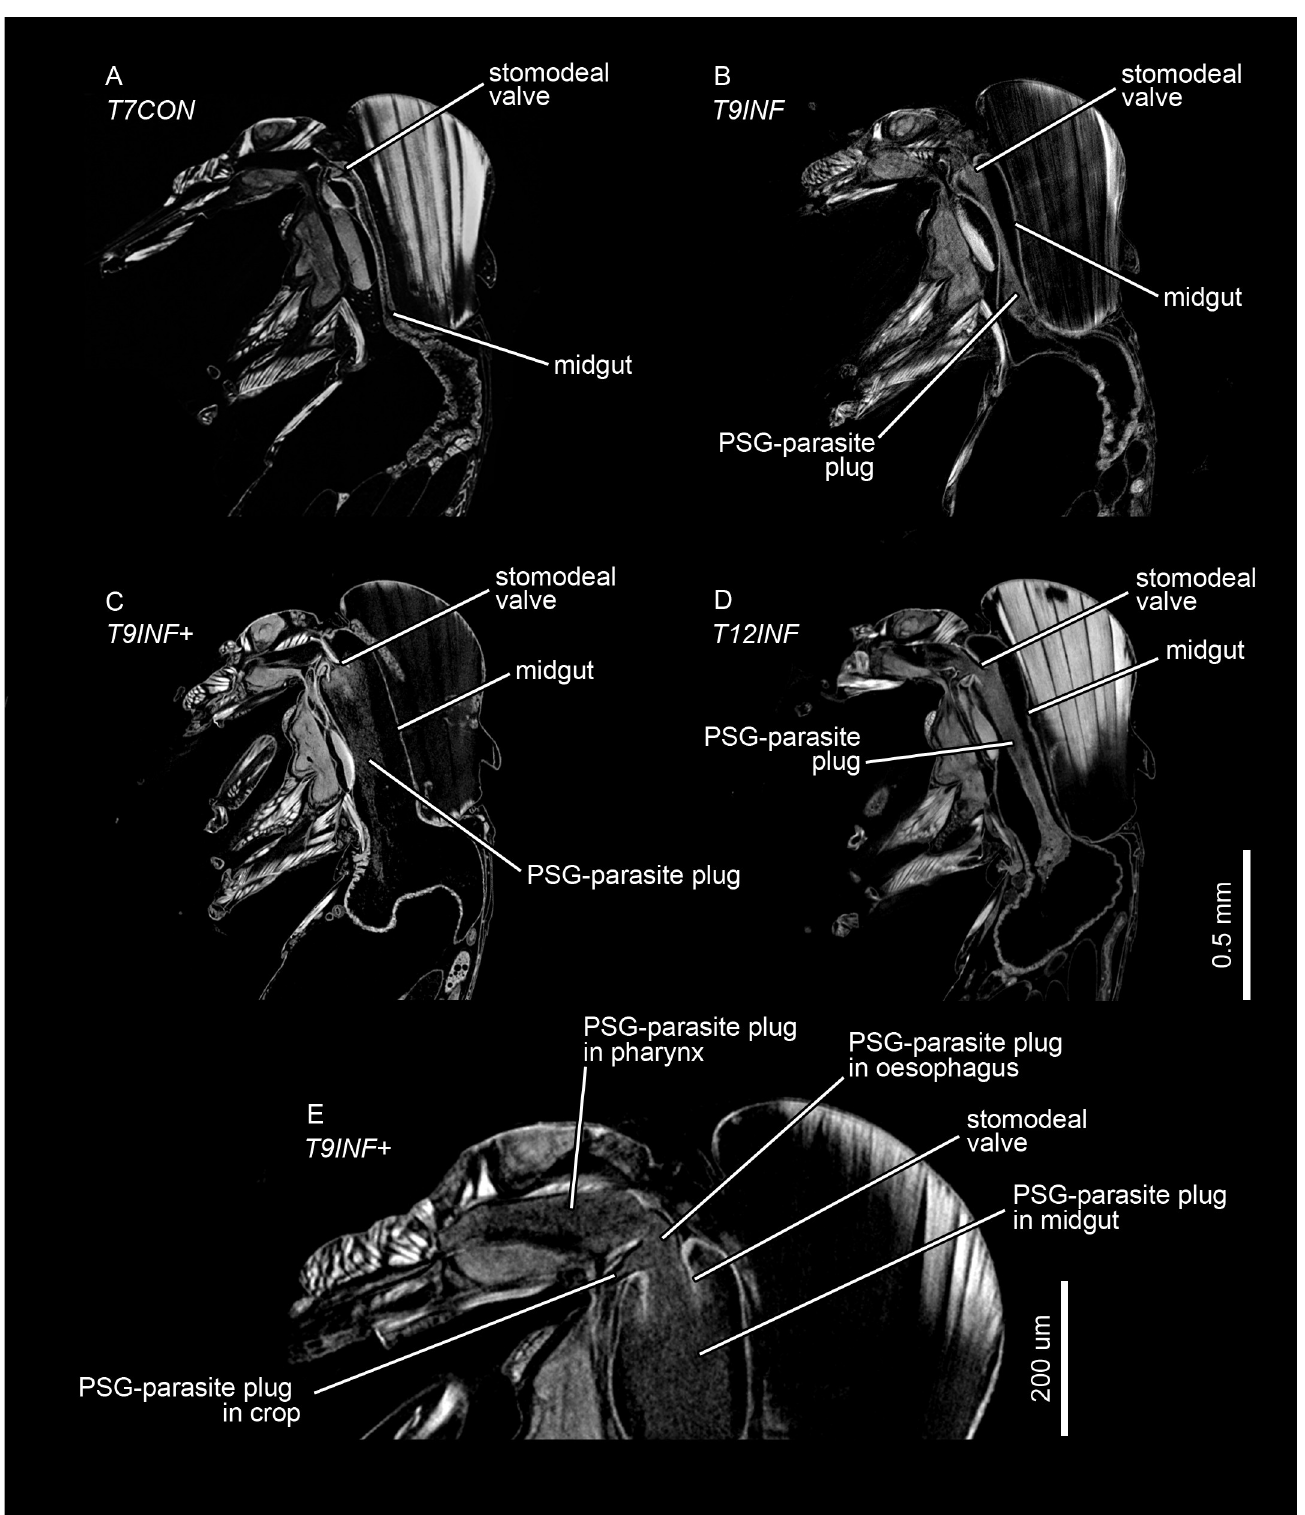
Fig 2. Micro-CT based virtual sections of L . longipalpis females after different feeding and post-infection periods. T7CON flies were 7 days after a non- infected blood meal. T9INF and T12INF flies were 9 and 12 days, respectively, after an infected blood meal. T6INF+ and T9INF+ flies were 6 and 9 days, respectively after an infected blood meal and 1 and 4 days, respectively, after a second, non-infected blood meal. (A-D) Sagittal sections. (E) Sagittal section of T9INF+ fly, showing PSG-parasite plug in the foregut (oesophagus, pharynx and crop).